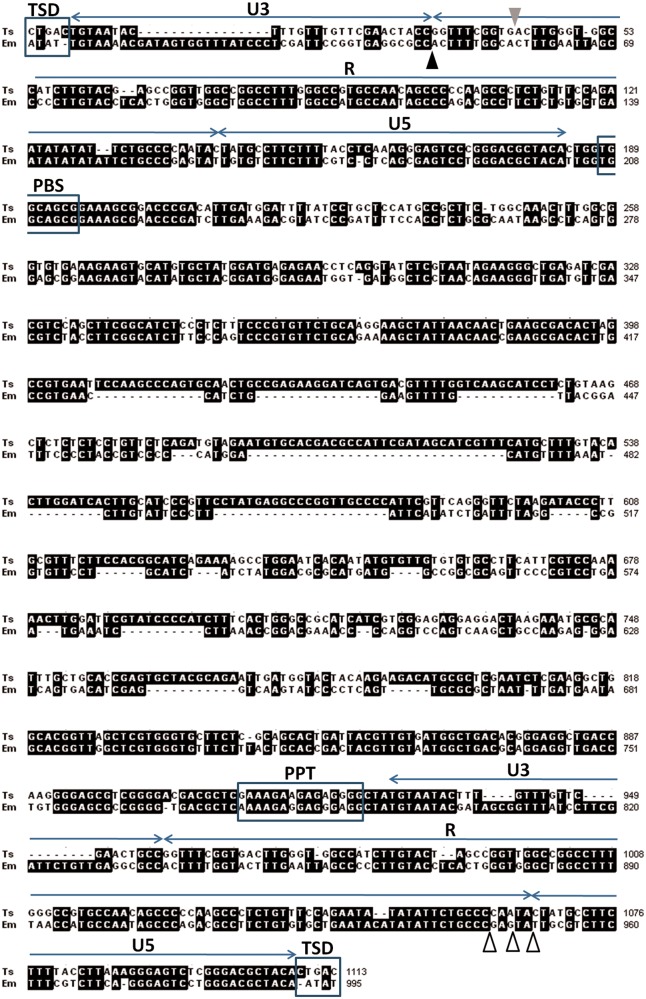
Alignment of ta-TRIMs from E. multilocularis (Em) and T. solium (Ts). The limits of the U3, R, and U5 regions of the LTRs are indicated above for Em. The arrowheads in the 5′-LTR show the beginning of transcription in Em elements (black), and Ts (gray), as determined from full length ESTs. White arrowheads in the 3′-LTR show the 3′-end of ta-TRIM transcripts in Em, as determined from full length ESTs and 3′-RACE experiments.